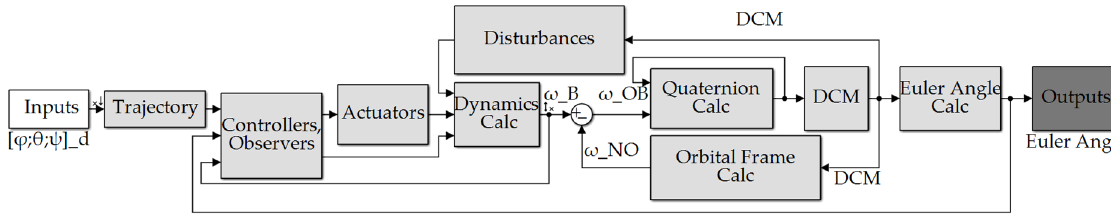
Figure A1. Simulink model overview.